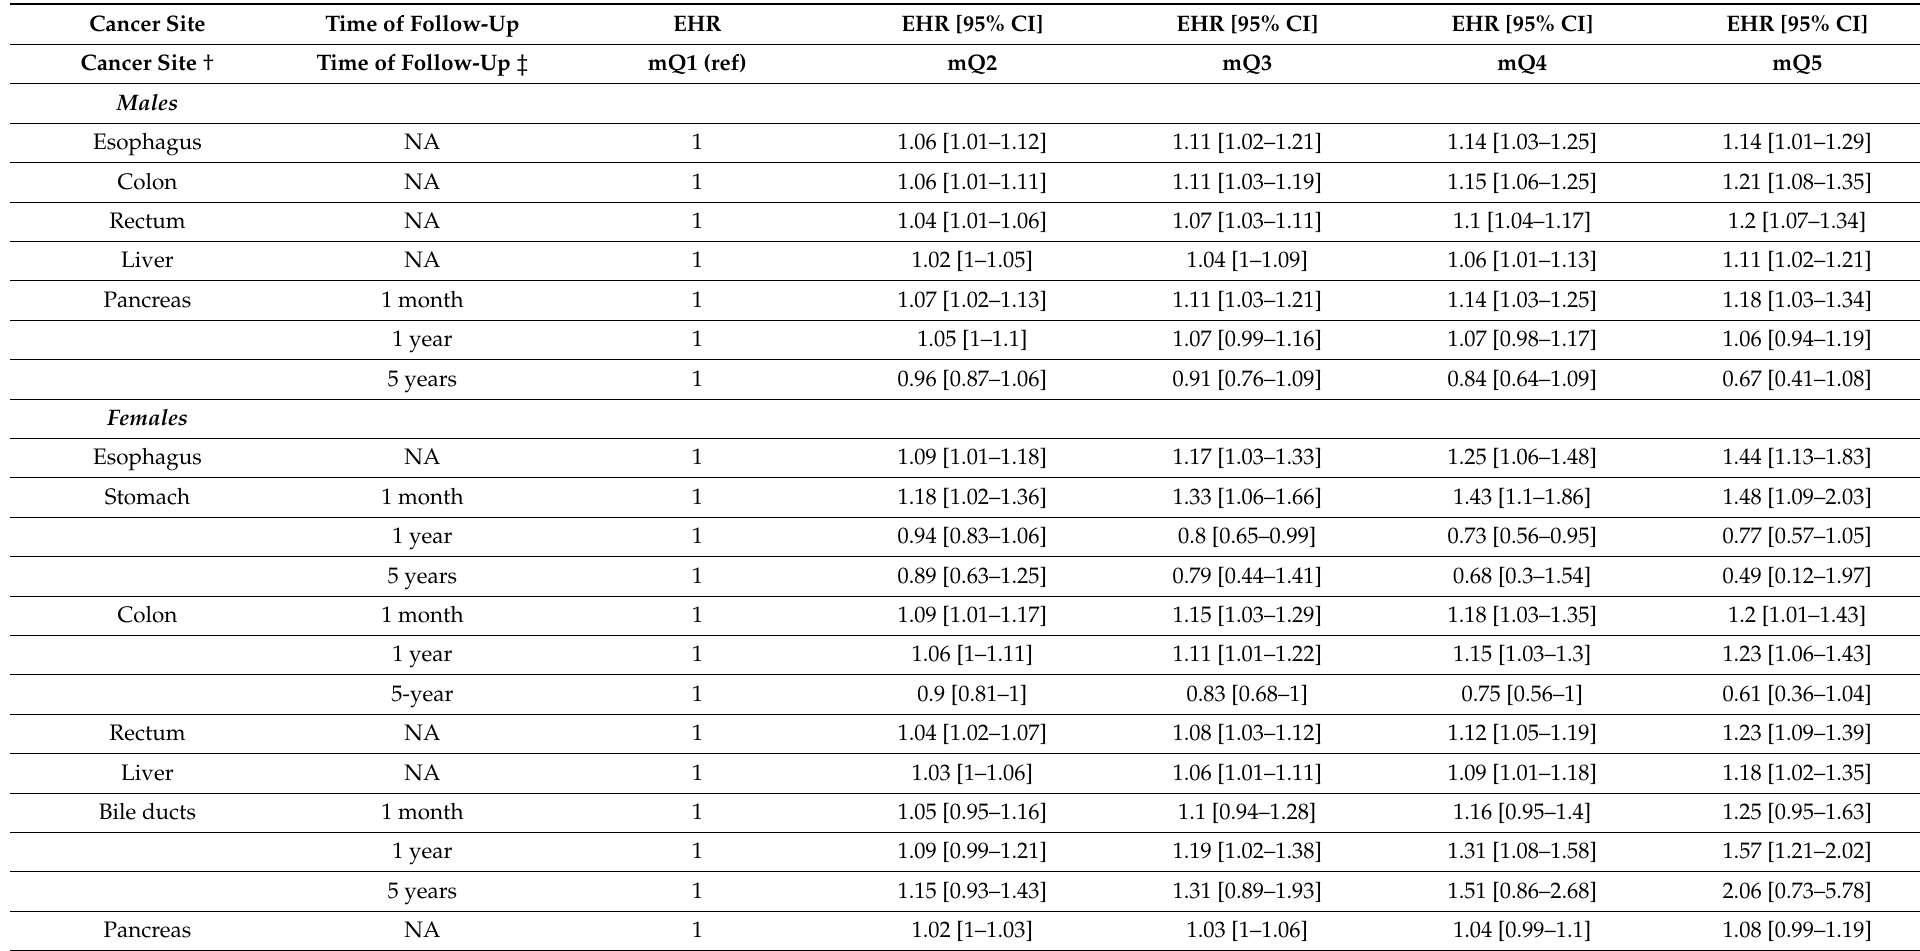
Table 3. Excess mortality hazard ratio (EHR) estimates for median value of national deprivation quintiles according to sex and cancer